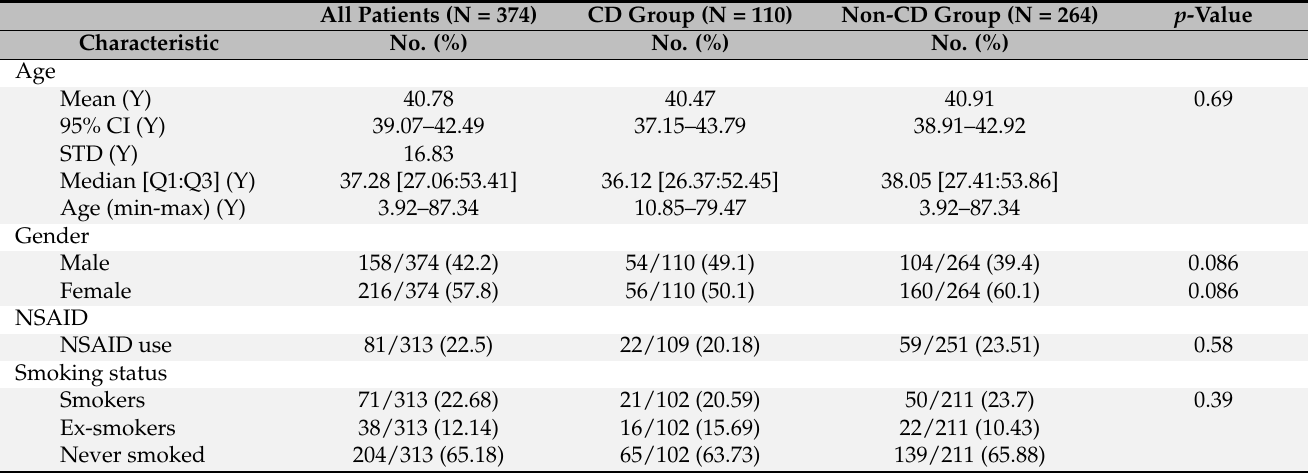
Table 1. Demographics of the patients included in the